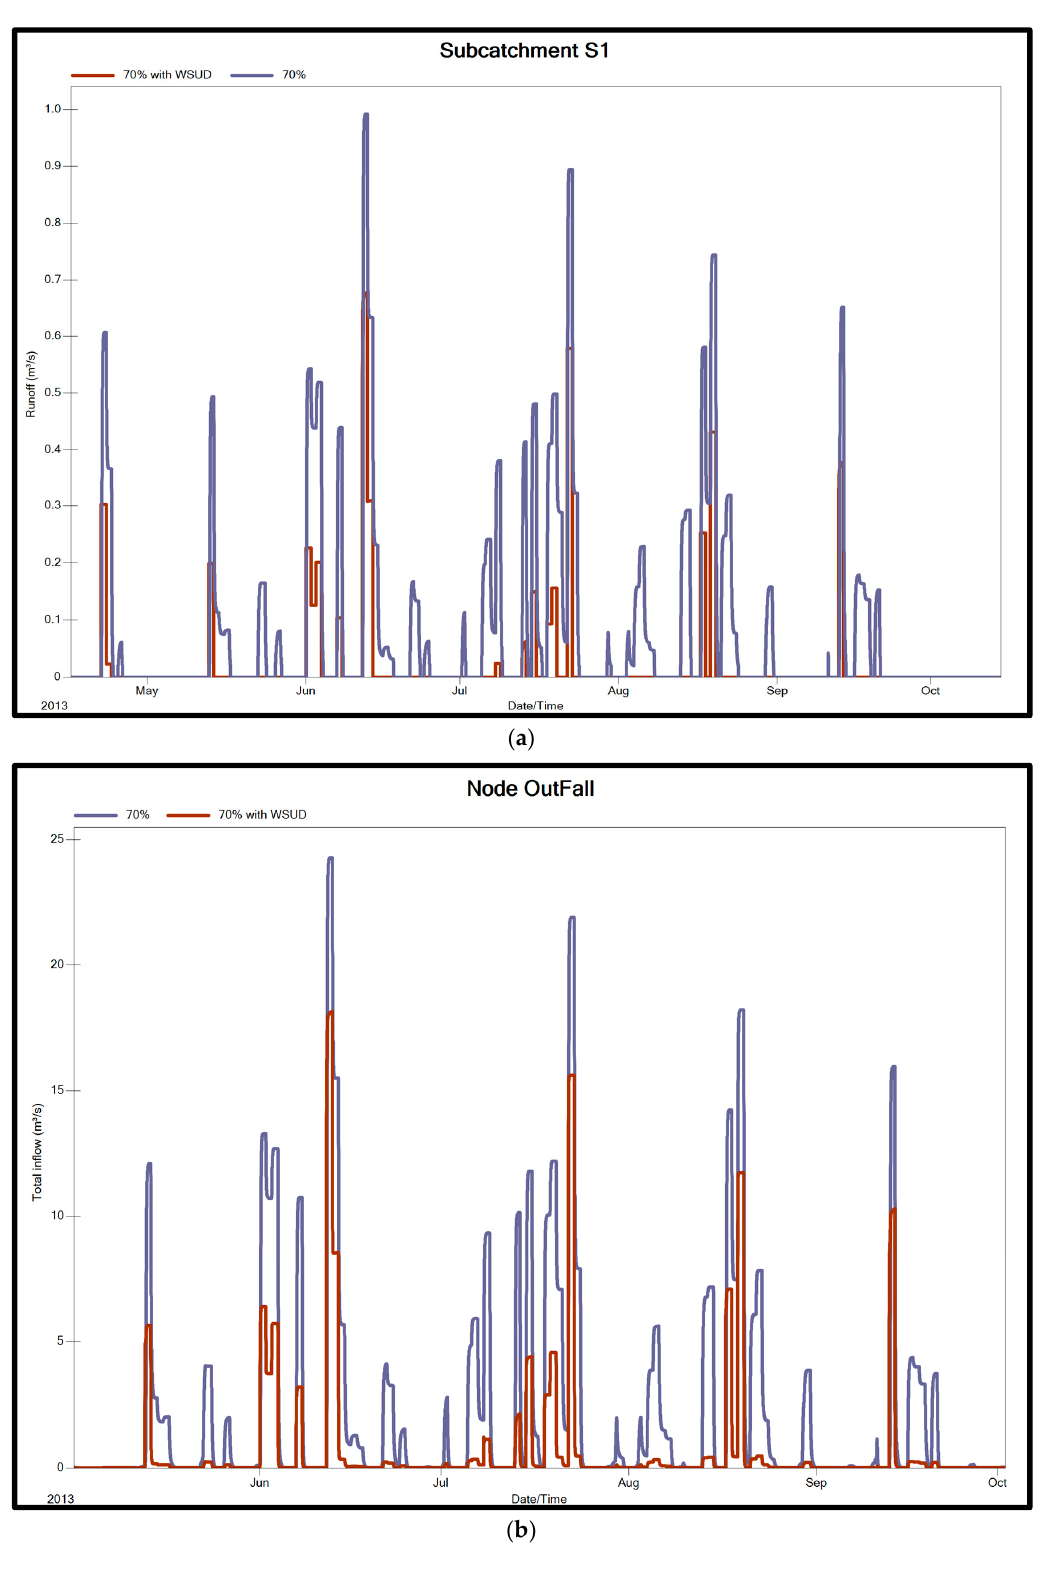
Figure 11. ( a ) Runoff comparison before and after Water Sensitive Urban Design (WSUD) for sub ‐ catchment S1; ( b ) Runoff comparison before and after WSUD for the Myponga catchment outfall.